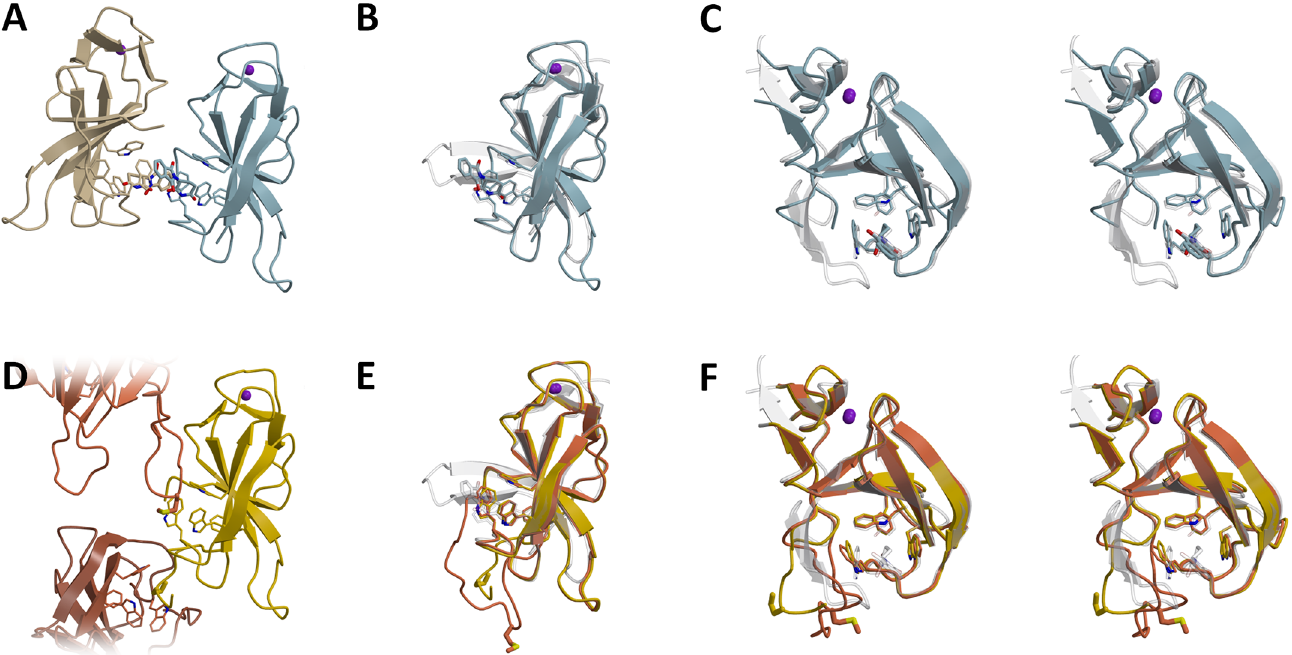
Fig 6. The thalidomide binding domain of mouse cereblon exhibits flexibility comparable to MsCI4. The mouse domain in complex with (blue, sand) and without thalidomide (yellow, shades of brown) is compared to MsCI4 (cid:129) thalidomide (transparent white). (A) Two thalidomide-bound domains from 4TZC arranged as an intertwined dimer. (B) Superposition of one monomer to MsCI4 (cid:129) thalidomide, illustrating the unfolded nature of the first flexible region. (C) Same as (B) but from another perspective, in stereo. (D) Apo mouse domains in 3WX2 are found in two conformations, “ yellow ” and “ brown ” , forming an endless array of interactions in the crystal lattice. (E) Superposition of both apo conformations onto MsCI4 (cid:129) thalidomide, showing the first flexible region in different conformations. (F) Same as (E) but from another perspective, in stereo. Note that the conformation of the tryptophans on the left is reminiscent of the flipped tryptophan in the intertwined MsCI4